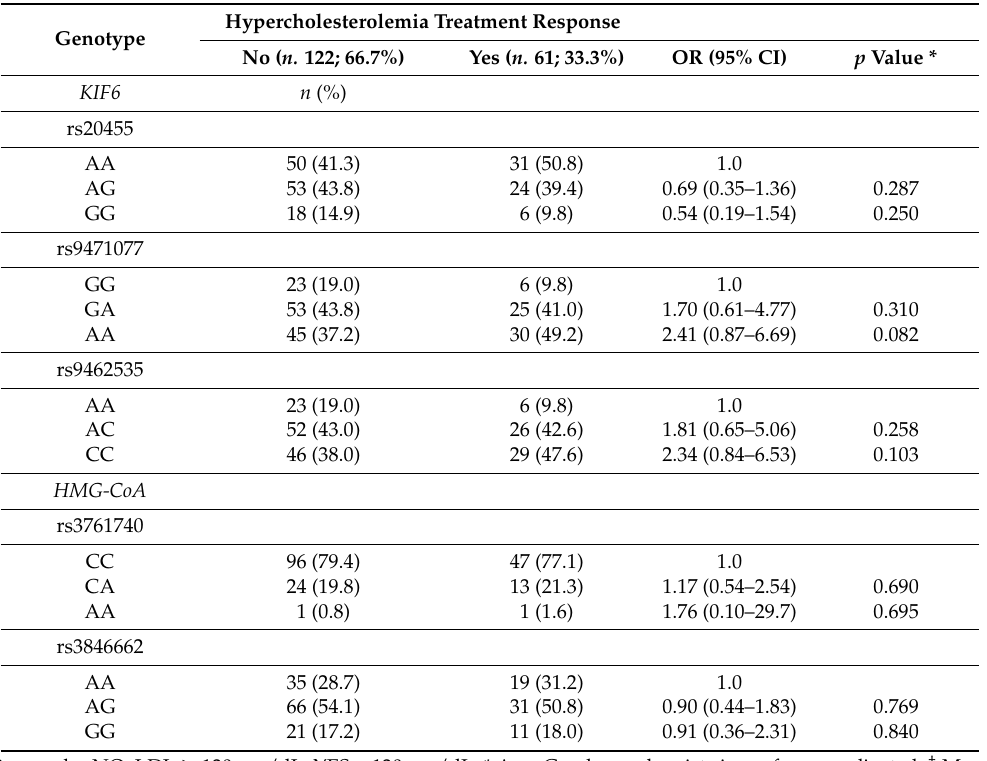
Table 7. Influence of KIF6 and HMG-CoA genotypes † on hypercholesterolemia treatment